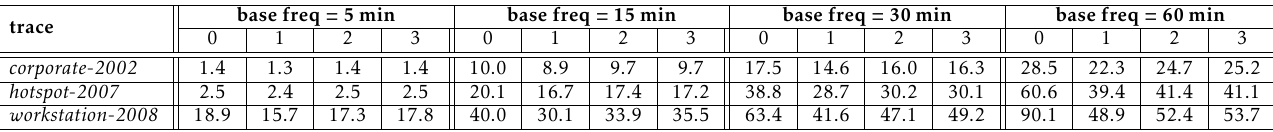
Table 1. Cumulative percentage of times when node went offline before subsequent update propagation